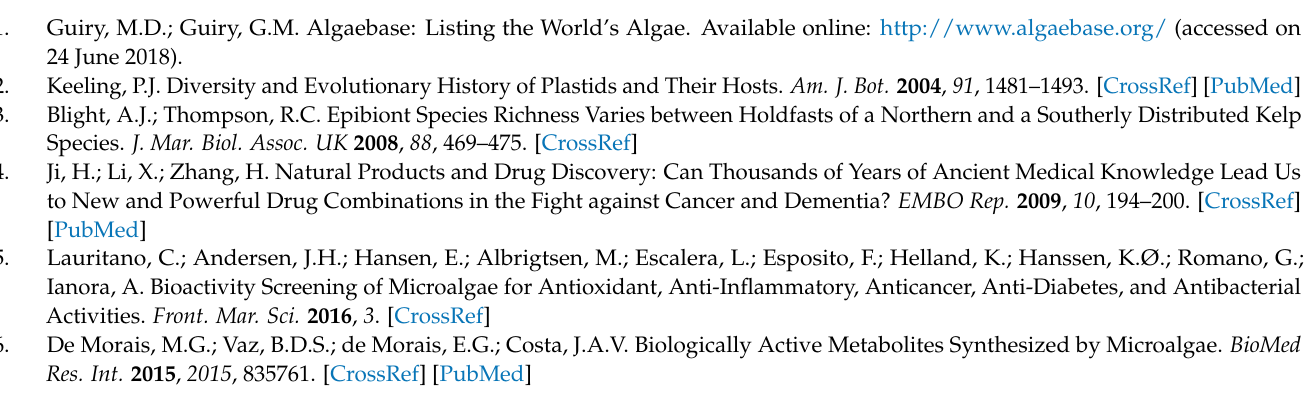
Figure S1: Bar chart specifying number of MS features detected for each sample in Figure 2 from main text, Figure S2: Bar chart specifying number of mass spectrometry (MS) features detected for each sample in Figure 5 from main text. Figure S3: Example of primary screening on extracts in PPAR α